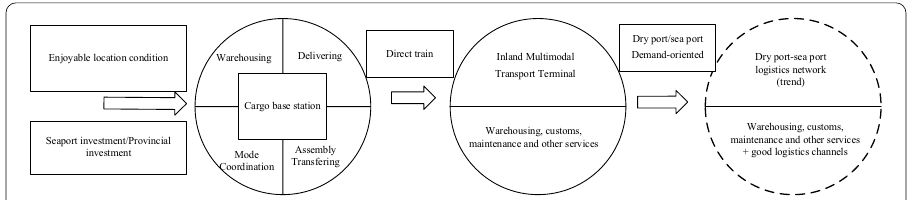
Fig. 6 The evolution of seaport-land port in Shandong